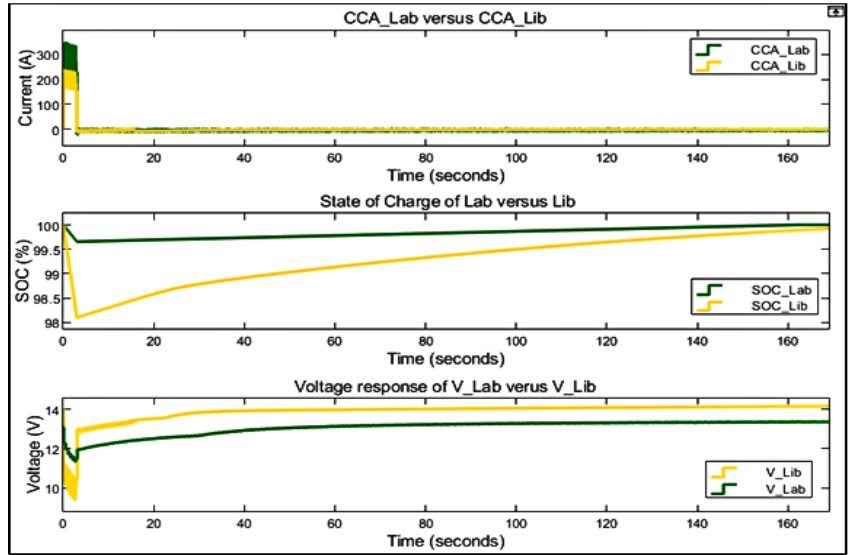
Figure 13. Required CCA, SoC and voltage response of HESS during charging mode for case two (b).